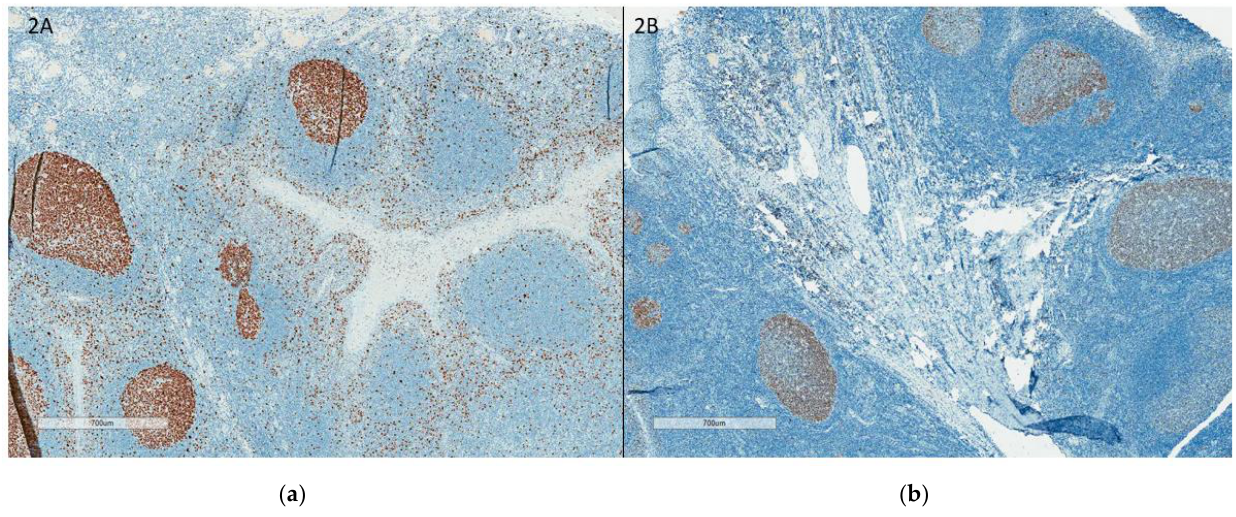
Figure 1. ( a ) Tonsil with good staining, accepted external control; ( b ): Tonsil with weak staining, rejected external control. ( a , b ) illustrates the tonsil as external control with good staining ( a ) and with weak staining ( b Figure 1. ( A ) Tonsil with good staining, accepted external control; ( B ) : Tonsil with weak staining, rejected external control. ( A,B ) illustrates the tonsil as external control with good staining ( A ) and with weak staining ( B ).